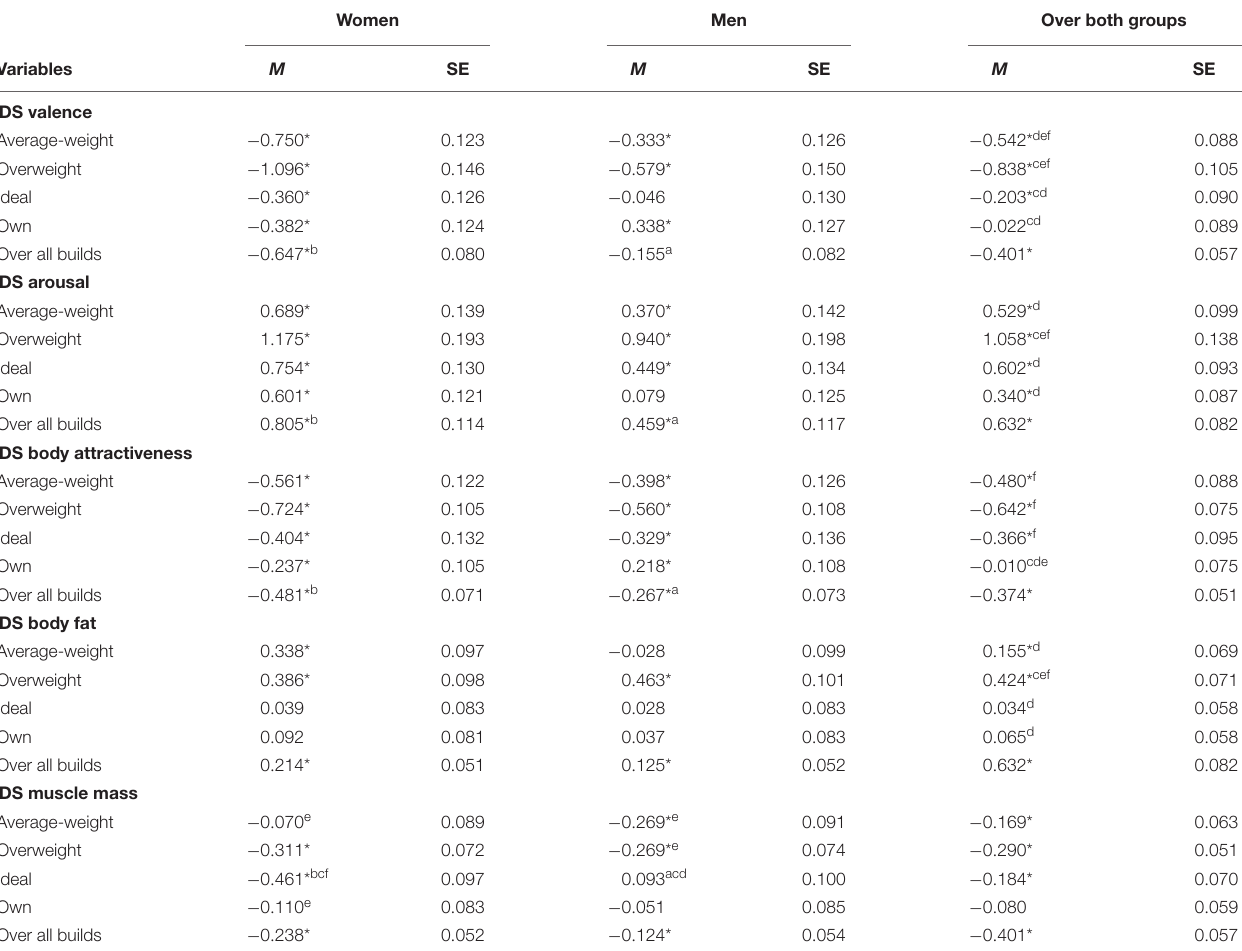
TABLE 1 | Means, standard errors, confidence intervals of the means, and results for the post-hoc t -tests for the double standards dependent on the factors Group and Build. Women Men Over both